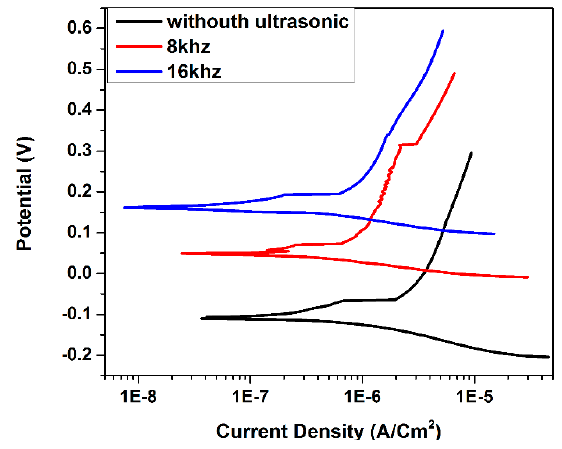
Figure 4. Tafel plots of TiN coated samples after ultrasonic treated at 8 kHz and 16 kHz.